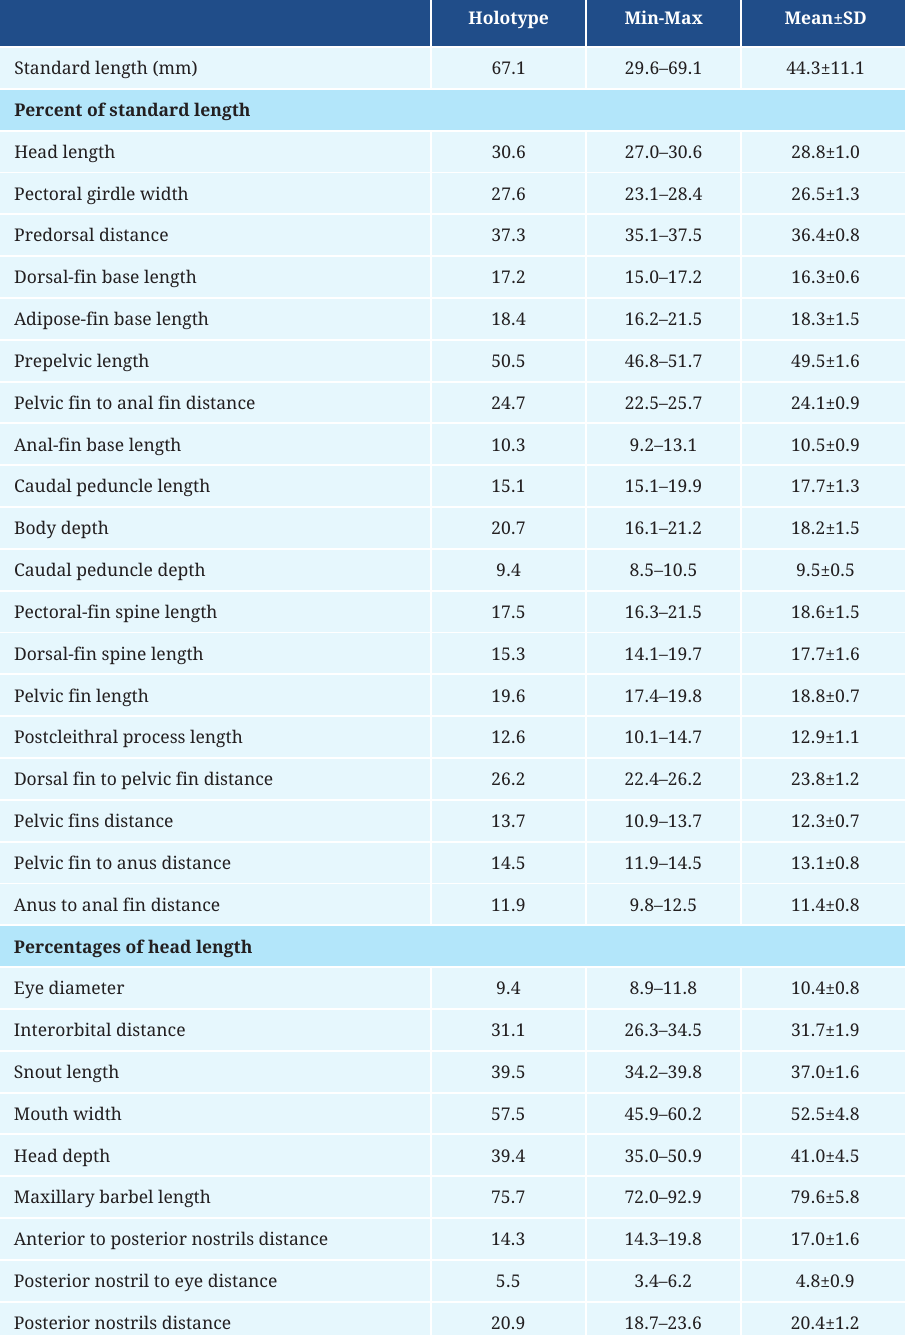
TABLE 1 | Morphometry of Rhyacoglanis varii from upper rio Tocantins basin (n = 42). Statistics of minimum (Min), maximum (Max), mean, and standard deviation (SD) include